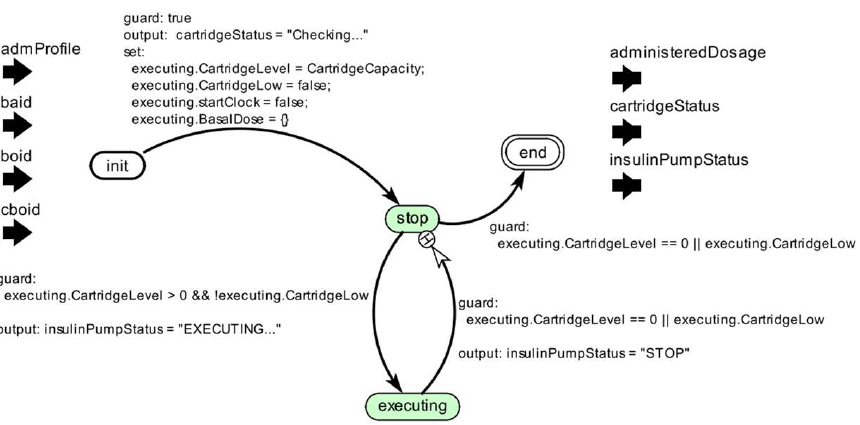
Figure 9. Insulin Pump Model’s